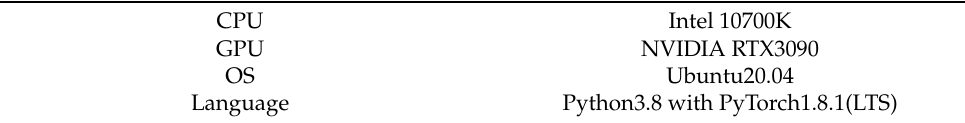
Table 3. System requirements.